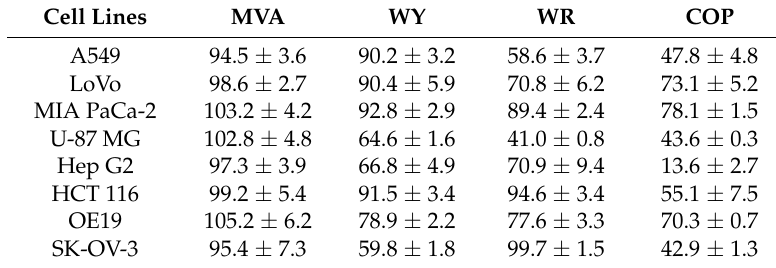
Table 1. Percentage of surviving cells infected by four strains of vaccinia virus (VACV) used in this study. Various human tumor cell lines were infected by the four parental VACV strains (MVA, WY, WR and COP) at Multiplicity of Infection (MOI) 10 –5 . Survival was determined 5 days later, as described in the Materials and Methods section. Cell viability results are expressed as the percentage of viable cells relative to non-infected cells. Values are expressed as mean ± SD of three individual infections.